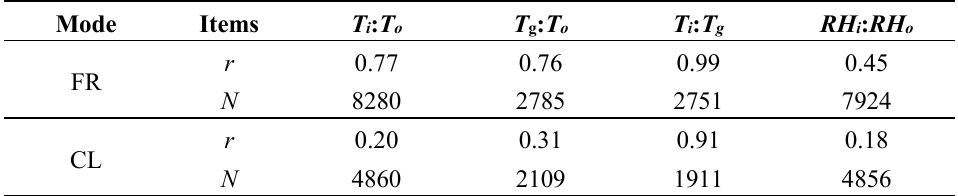
Figure 2. Monthly mean values with 95% confidence interval (Error bar): ( a ) temperature; ( b ) relative humidity; ( c ) absolute humidity. Table 4. The correlation coefficient.